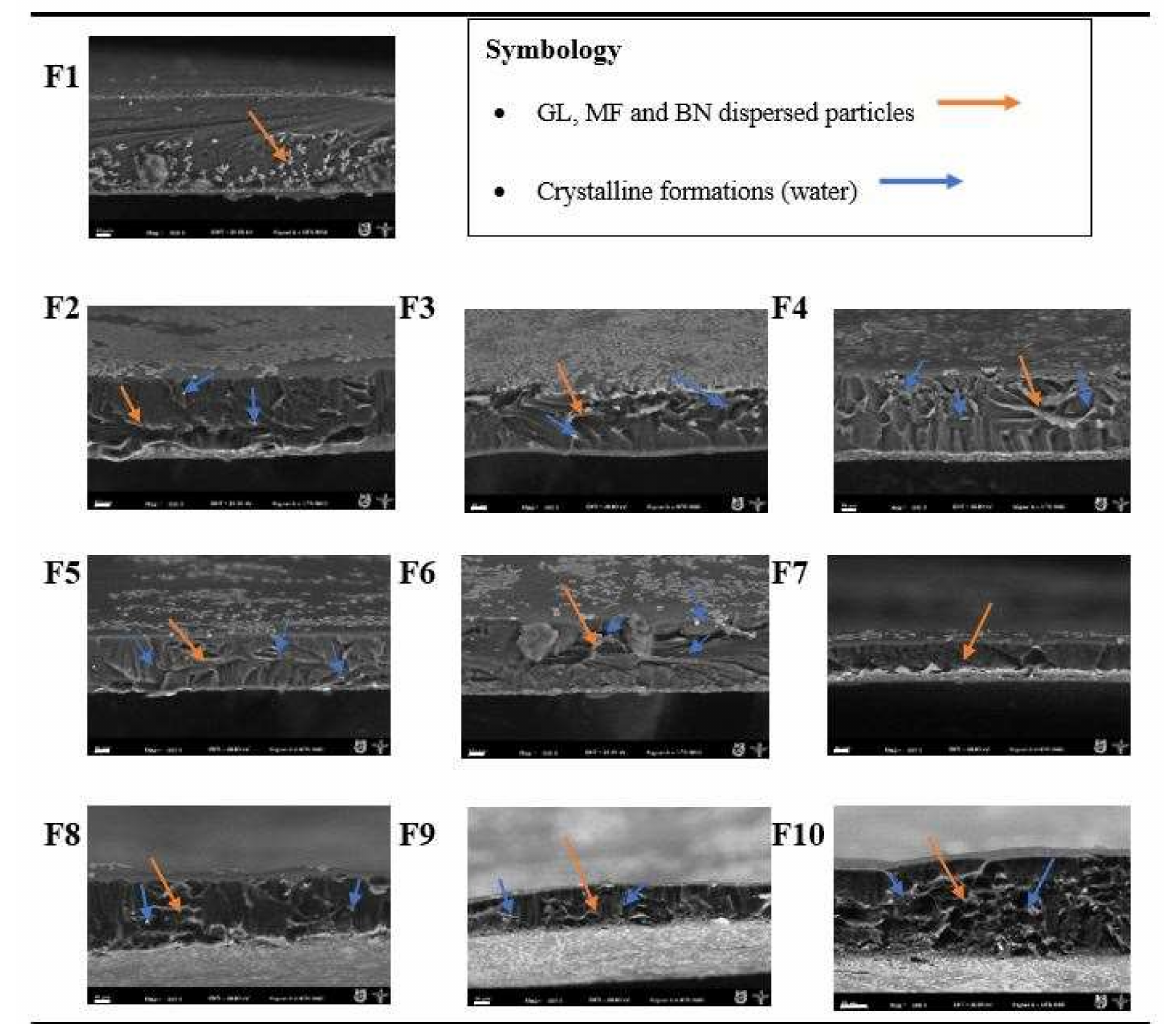
Figure 2. Cross-sectional micrographs obtained by scanning electron microscopy (SEM) of the reinforced gelatin biofilms. The scale bar indicates 10 µ m, SEM magnification: 500 × . F1: control sample; F2–F4: samples with microfiber; F5–F7: samples with bentonite; F8–F10: samples with microfiber and bentonite. MF = Agave microfiber; BN = Bentonite; GL = Gelatin; GLY = Glycerol; DW =